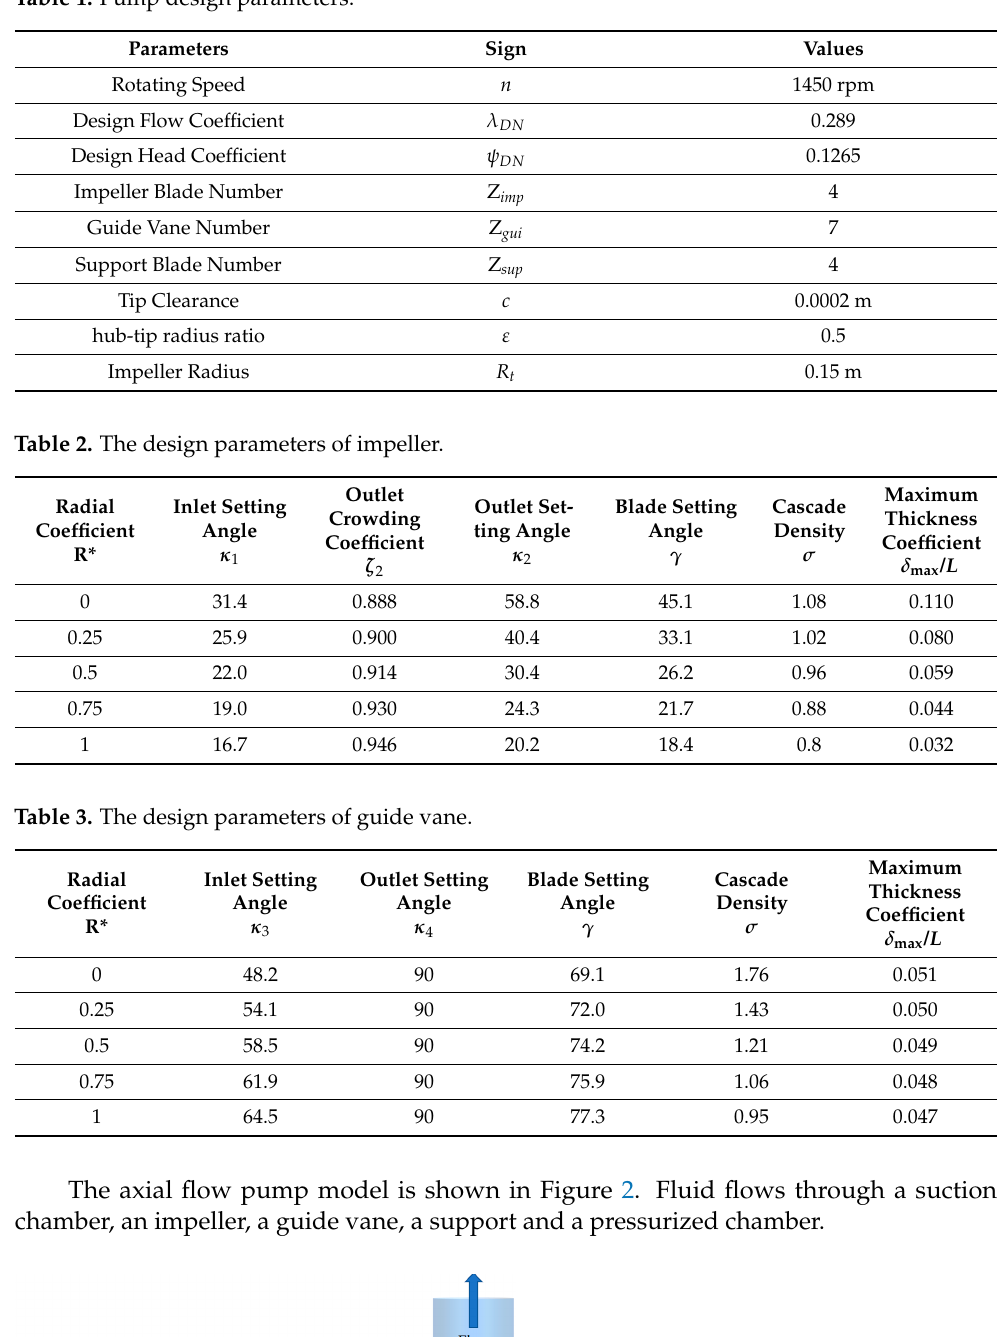
Table 1. Pump design parameters.